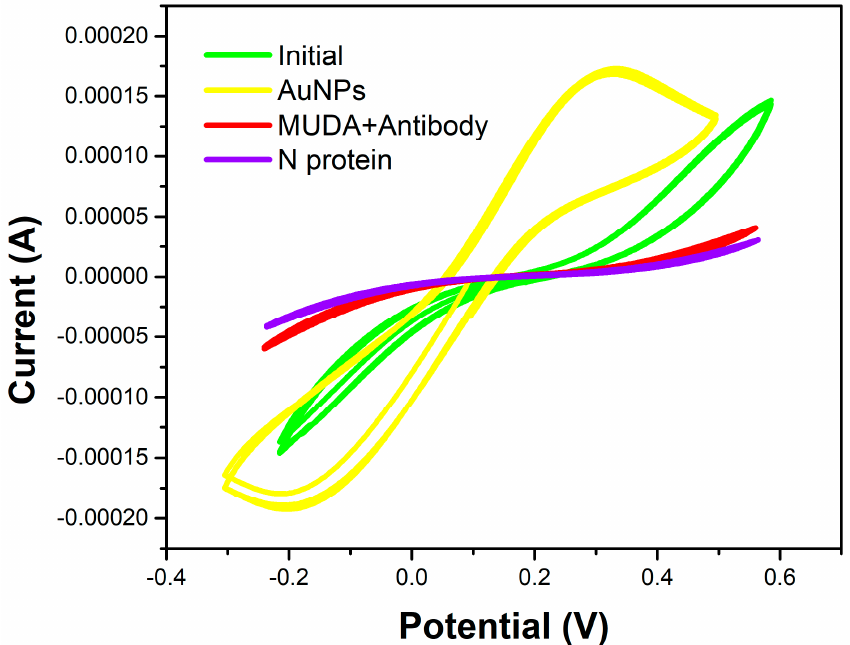
Figure A1. Cyclic voltammogram for the S6/02.08 sensor with measurements after AuNP decoration, MUDA functionalization + antibody immobilization (one step), and N-protein binding.